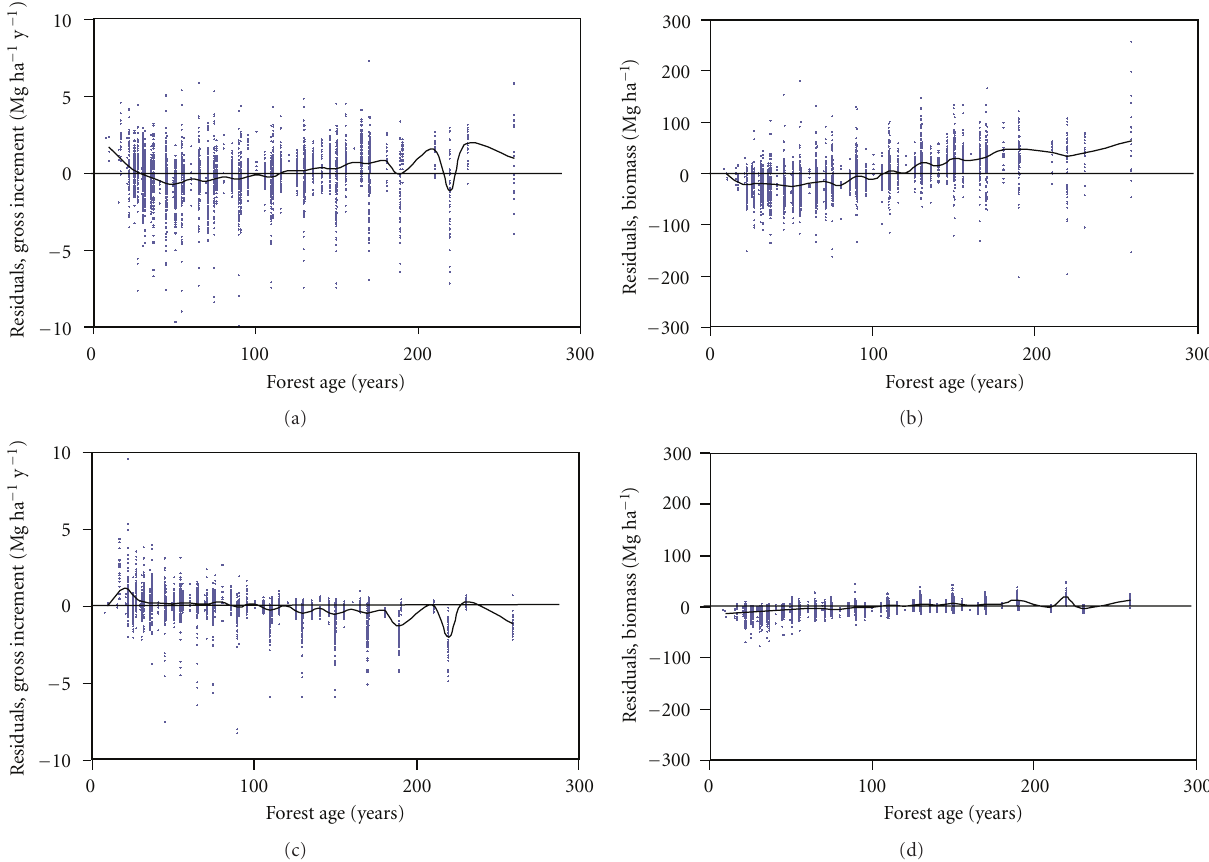
Figure 6: Residuals of modeled-measured values of gross increment and biomass versus forest age for all regions and species for model A (a, b) and model B (c, d). The linen depicts mean for 10-year age intervals. Table 4: Summary of inventory data and estimated mean closure (c) and model agreement with data for the tree species. Symbols and units in Table 1.